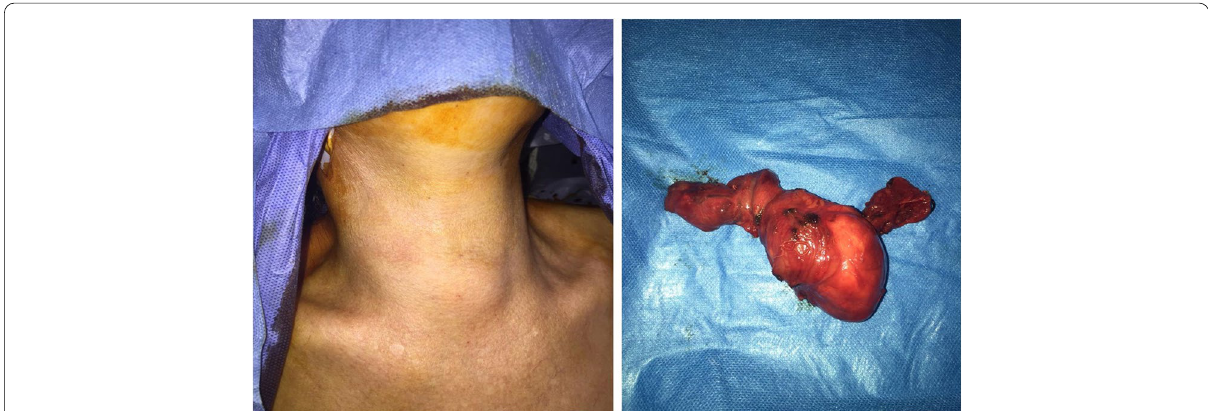
Fig. 1 A Preoperative photo showing the thyroid swelling with undefined lower border. B Postoperative photo of the resected thyroid gland showing replaced right lobe by large hard nodule